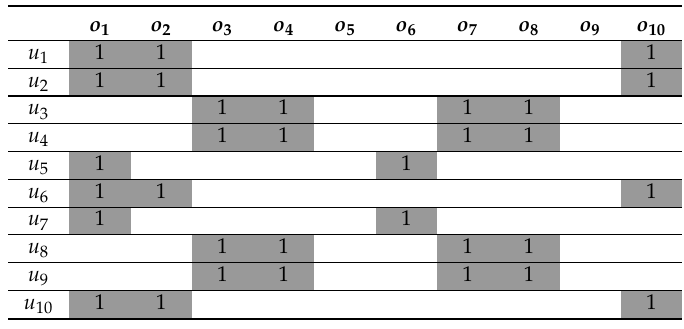
Table 5. Original matrix A op .